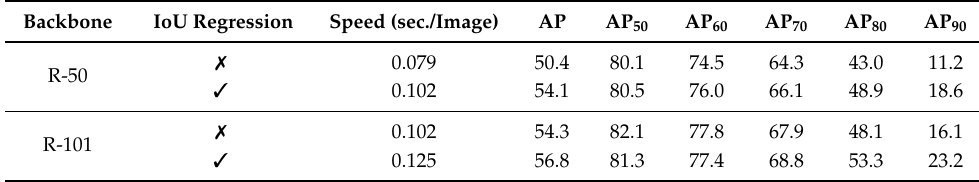
Table 6. Detection results on PASCAL VOC 2007 test.